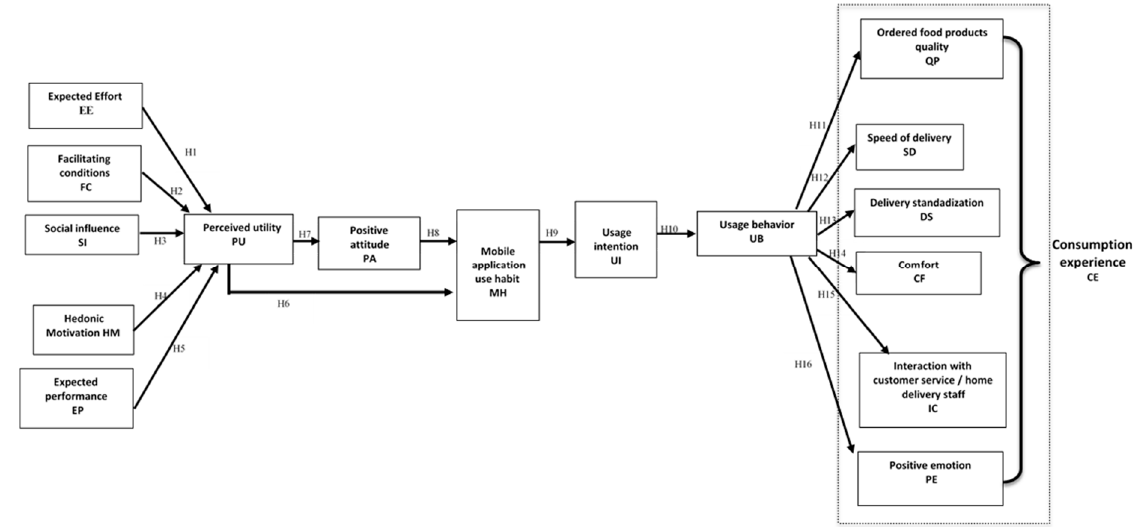
Figure 1. The proposed research conceptual model.